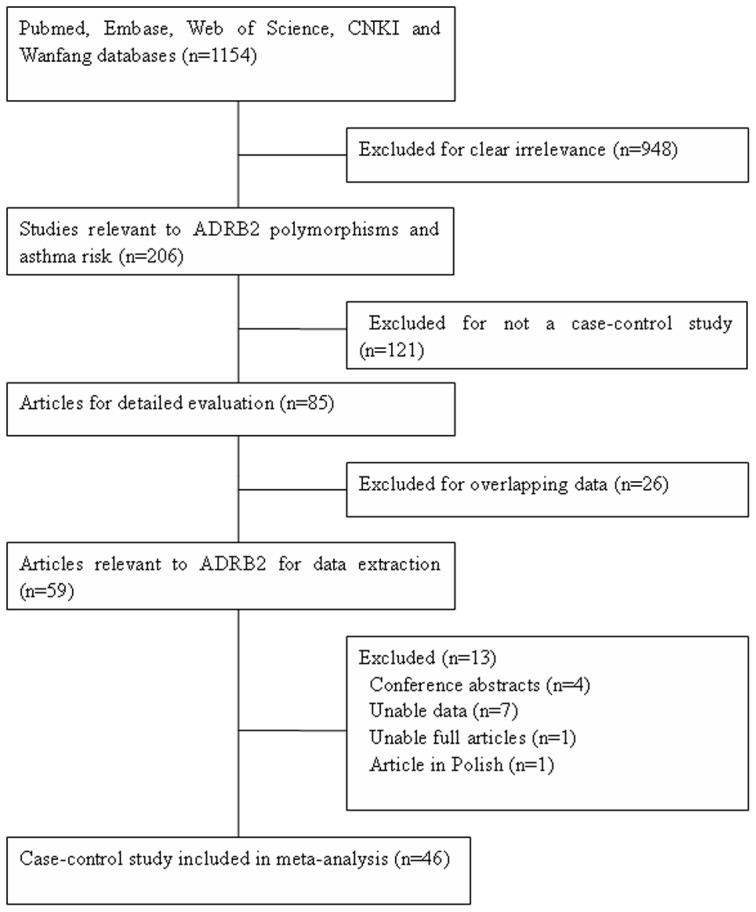
Flow diagram of included/excluded studies.